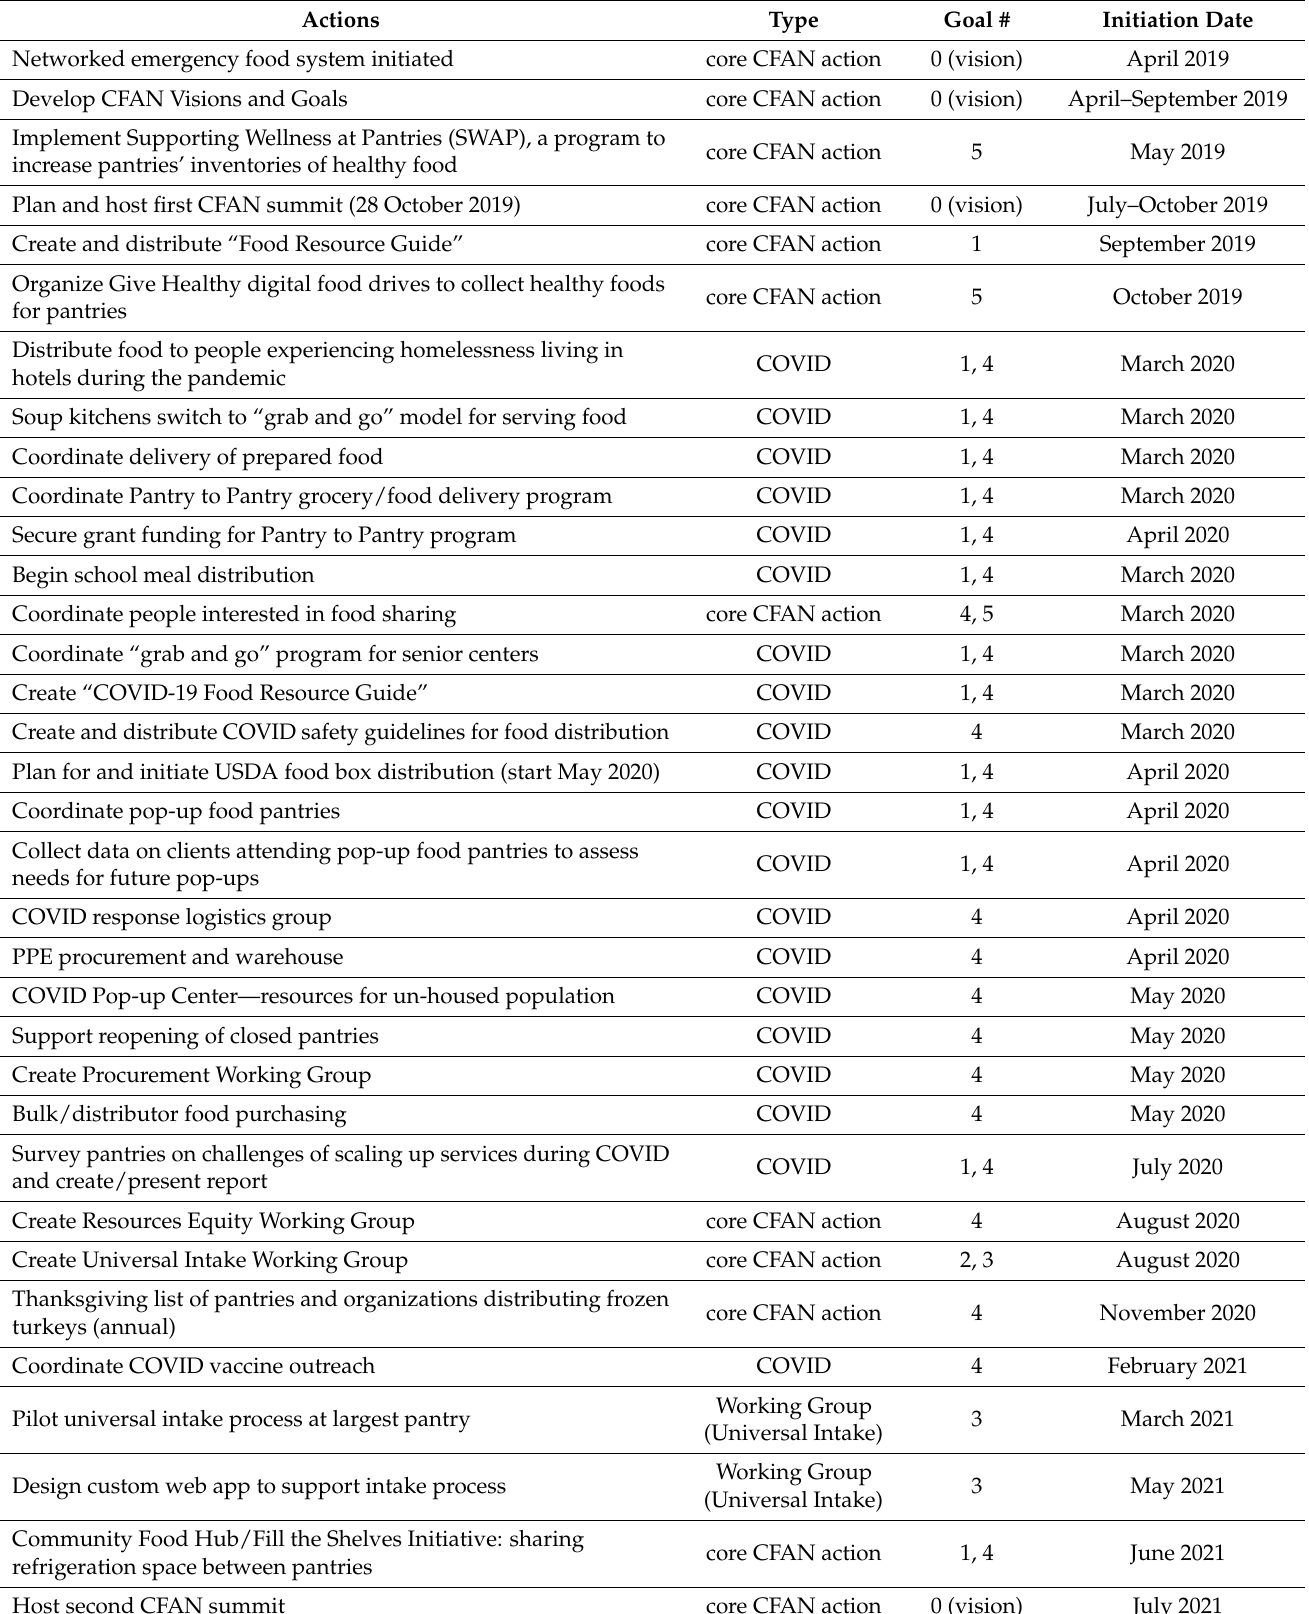
Table 3. Actions conducted by CFAN from April 2019 to March